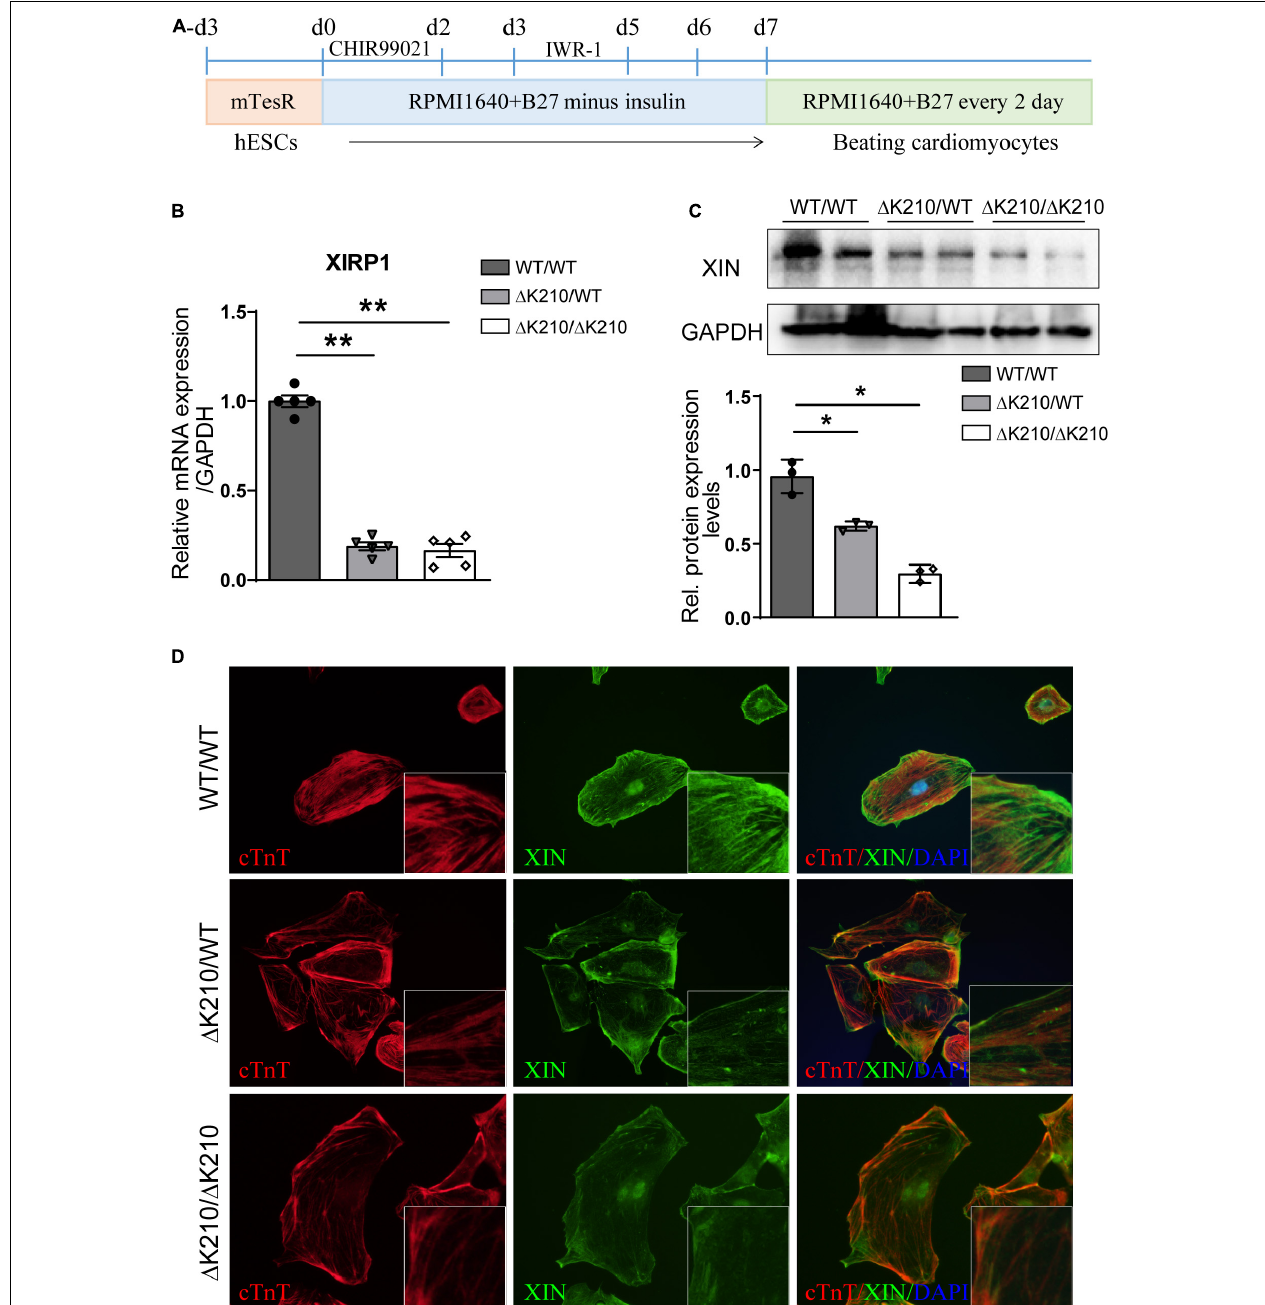
FIGURE 1 | Cardiac differentiation of TNNT2 - (cid:49) K210 mutant hESCs and the expression of XIN. (A) Schematics of optimized chemically defined cardiac differentiation protocol. (B) Quantitative PCR verification of XIRP1 expression in wild type (WT/WT), TNNT2 - (cid:49) K210 (heter: (cid:49) K210/WT, homo: (cid:49) K210/ (cid:49) K210) hESC-cardiomyocytes at day35 post cardiac differentiation. (C) Detection of XIN protein expression at day35 post differentiation by Western blotting. GAPDH was used as the loading control. (D) , Immunostaining detection of XIN (green) and cTnT (red) in cultured WT/WT, WT/ (cid:49) K210 and (cid:49) K210/ (cid:49) K210 cardiomyocytes. Data are represented as mean ± SEM. * P < 0.05, ** P <